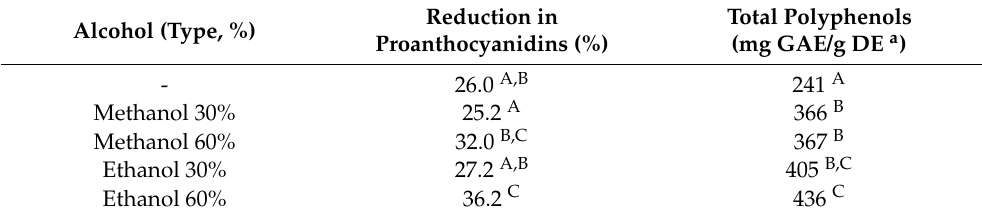
Table 1. Effect of the type and proportion of alcohol on the acid cleavage of proanthocyanidins in I. edulis leaf extract. The different superscript letters within each column refer to statistically significant differences ( p < 0.05) as resulting from ANOVA followed by Tukey